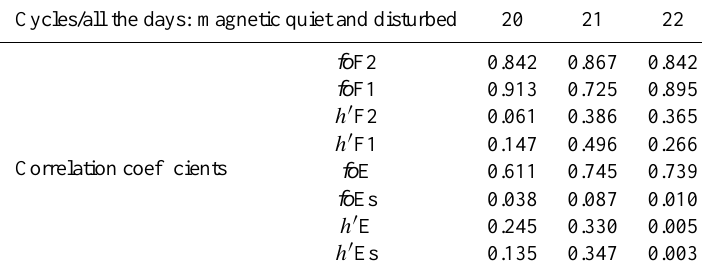
Table 3. Correlation coefficients between the ionospheric parameters and the sunspot number Rz during all magnetically disturbed and quiet days with am ≥ 20nT and am < 20nT. Cycles/all the days: magnetic quiet and